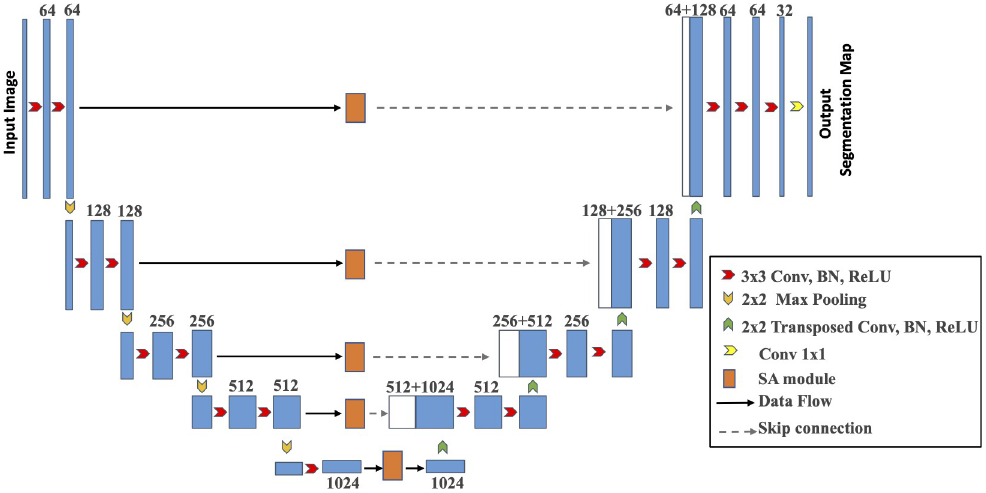
Fig 1. Diagram of the proposed